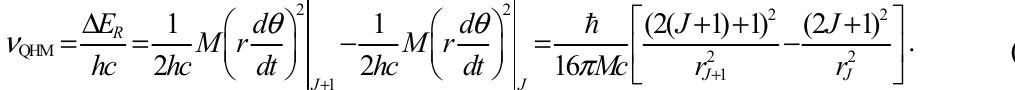
, (cid:2021) , (cid:2021) and (cid:2021) with the (cid:2928)(cid:2919)(cid:2917)(cid:2919)(cid:2914) (cid:2924)(cid:2925)(cid:2924)(cid:2928)(cid:2919)(cid:2917)(cid:2919)(cid:2914) (cid:2901)(cid:2892)(cid:2897) (cid:2916)(cid:2919)(cid:2930)(cid:2930)(cid:2919)(cid:2924)(cid:2917)